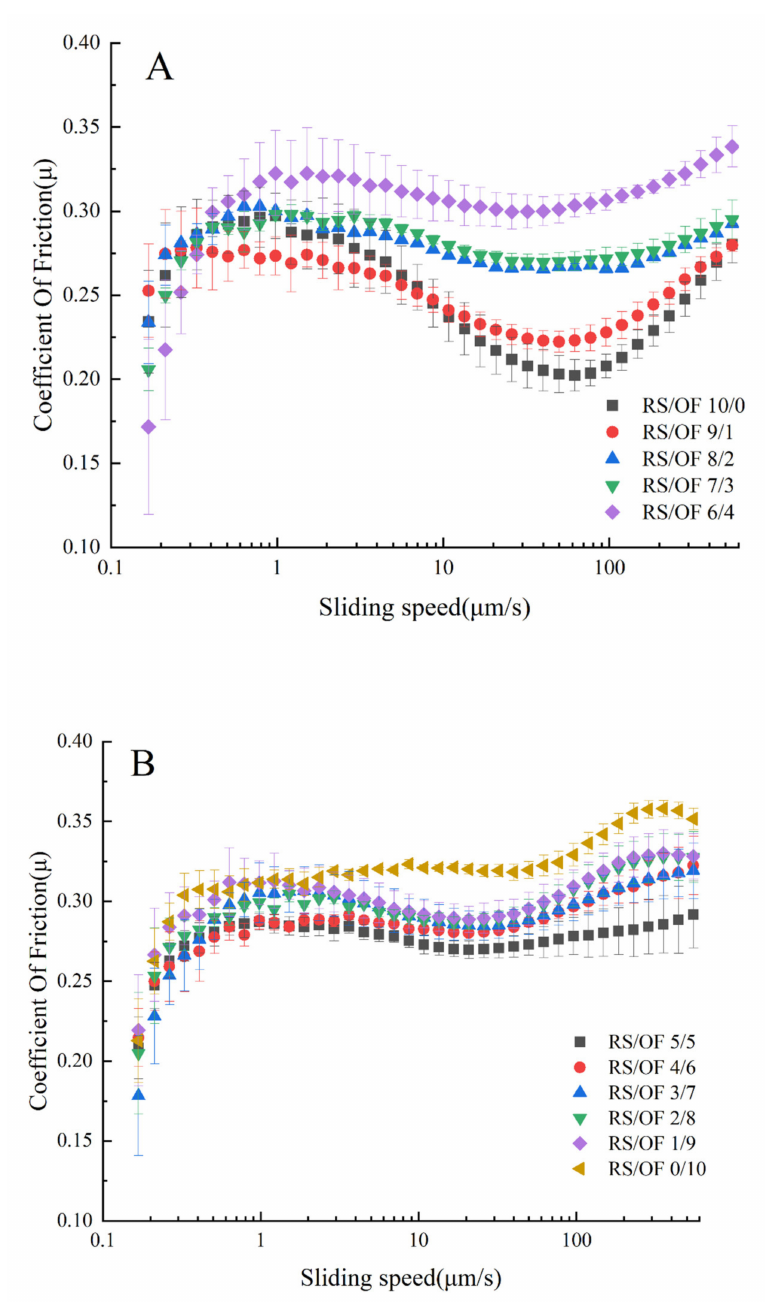
Figure 3. Friction characteristics of rice starch (RS) and oat flour (OF) mixtures with different ratios. ( A ) shows the coefficient of friction when RS is higher than OF. ( B ) shows the coefficient of friction when RS is lower or equal to